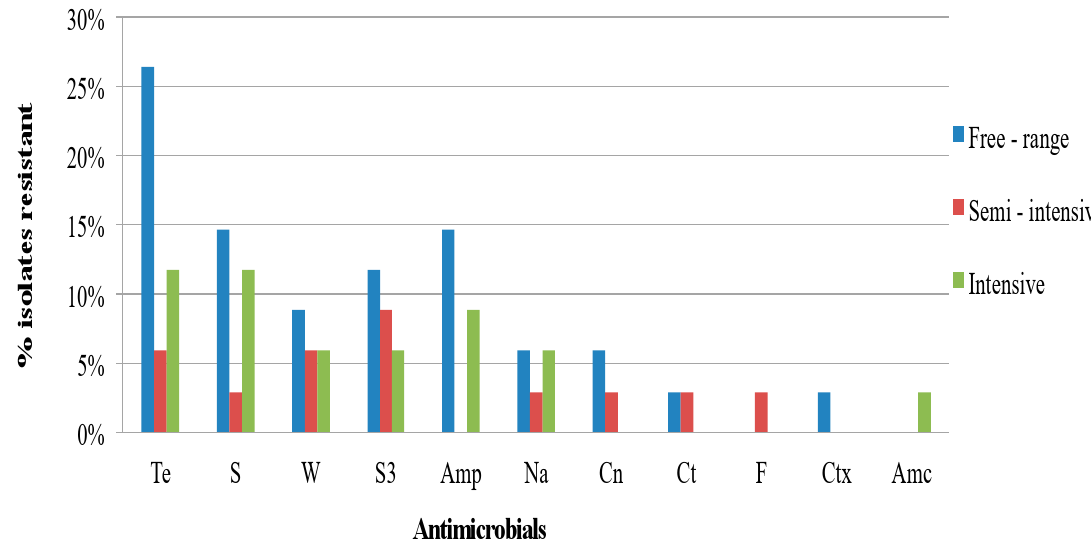
Figure 2. Frequency of resistance of Salmonella isolates recovered from village chickens of the South- central Peninsular Malaysia against antimicrobials according to the flocks with or without antibiotic use (Te, Tetracycline; S, Streptomycin; W, Trimethoprim; S3, Sulfonamides; Amp, Ampicillin; Na, Nalidixic acid; Cn, Gentamicin; Ct, Chloramphenicol; F, Nitrofurantoin; Ctx, Cefotaxime; Amc, Amoxicillin-clavulanate).